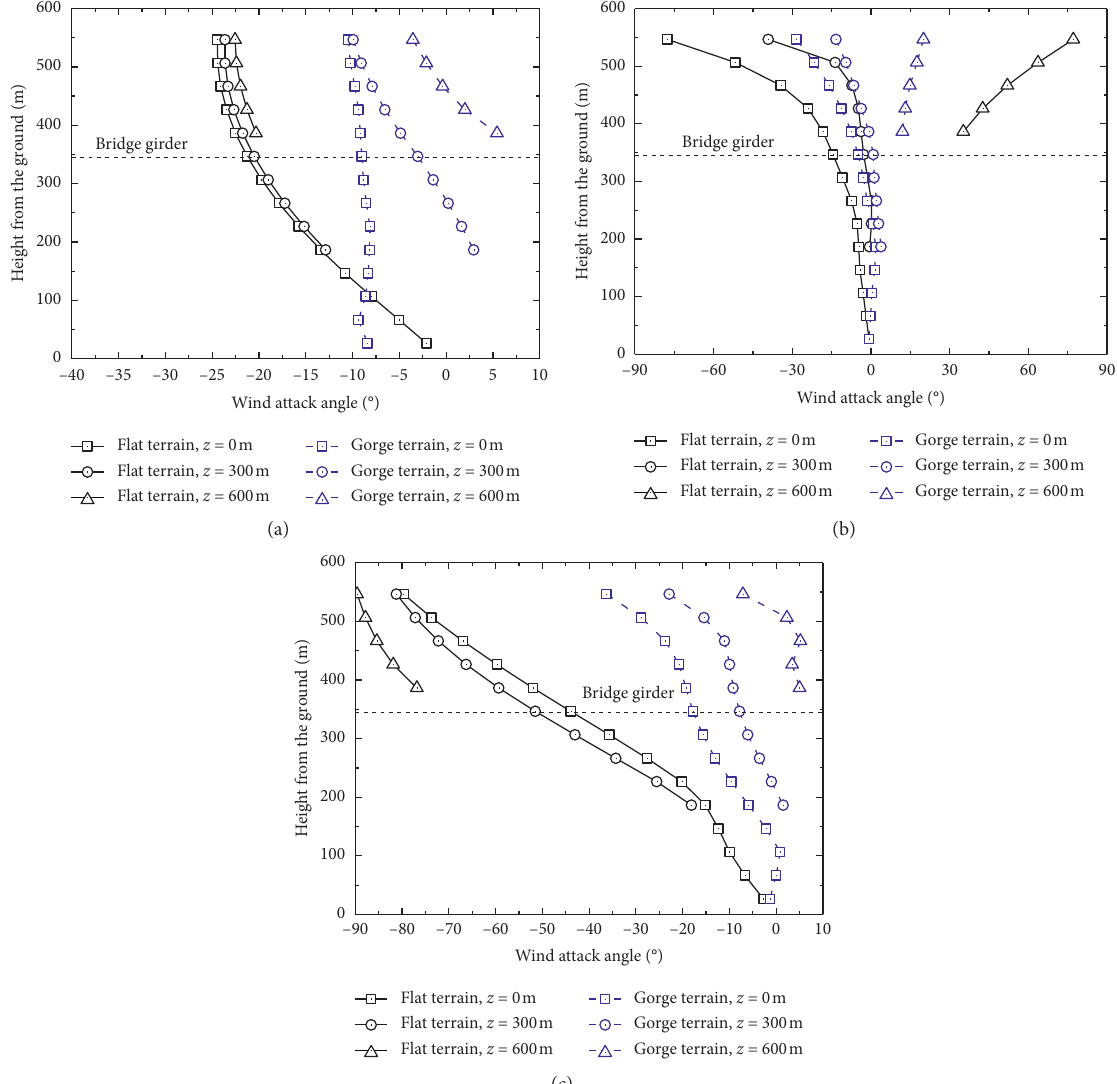
Figure 14: Distributions of vertical profile of wind attack angle in flat and gorge terrains at the three typical time. (a) t � 50s. (b) t � 100s. (c) t � 150 s.